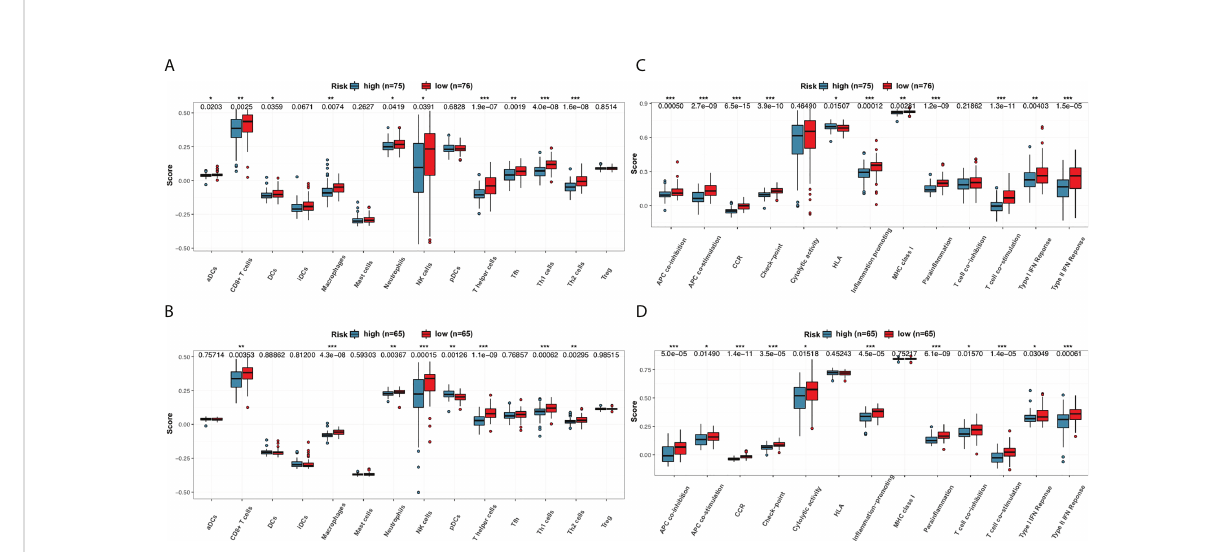
FIGURE 7 Comparison of the ssGSEA scores for immune cells and immune pathways. (A, B) Comparison of the enrichment scores of 14 types of immune cells between high- and low-risk subgroups in the 151-CLL-sample cohort and the 130-CLL-sample cohort. (C, D) Comparison of tumor immune status between high- and low-risk subgroups in the 151-CLL-sample cohort and the 130-CLL-sample cohort. p -values were shown as * p < 0.05; ** p < 0.01; *** p < 0.001.